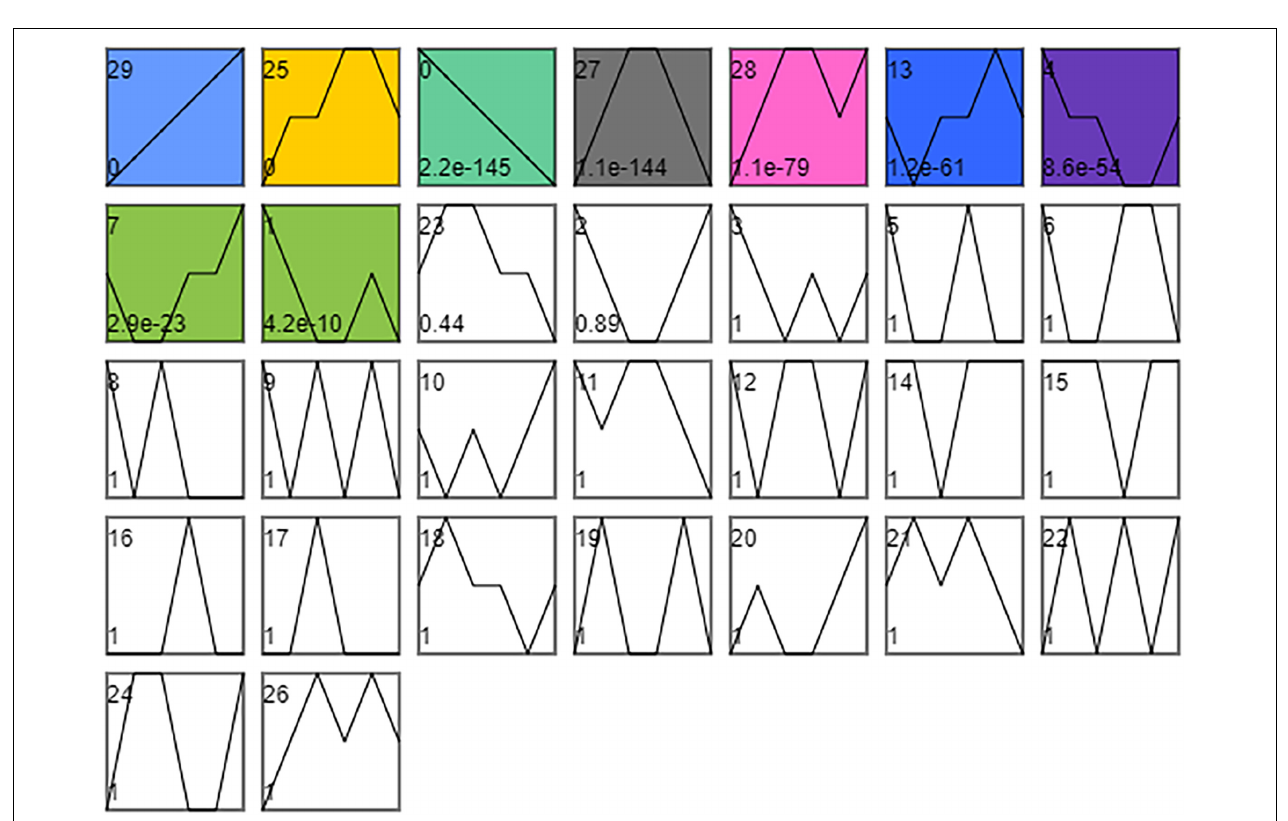
FIGURE 5 | STEM timing analysis of DEGs. Combine SI_1 and SI_2, SI_3 and SI_4, SI_5, and SI_6, SI_7 and SI_8, SI_9, and SI_10, SI_11, and SI_12 into 6 orders. The number of time series profiles is 30. The significance level is p < 0.01.